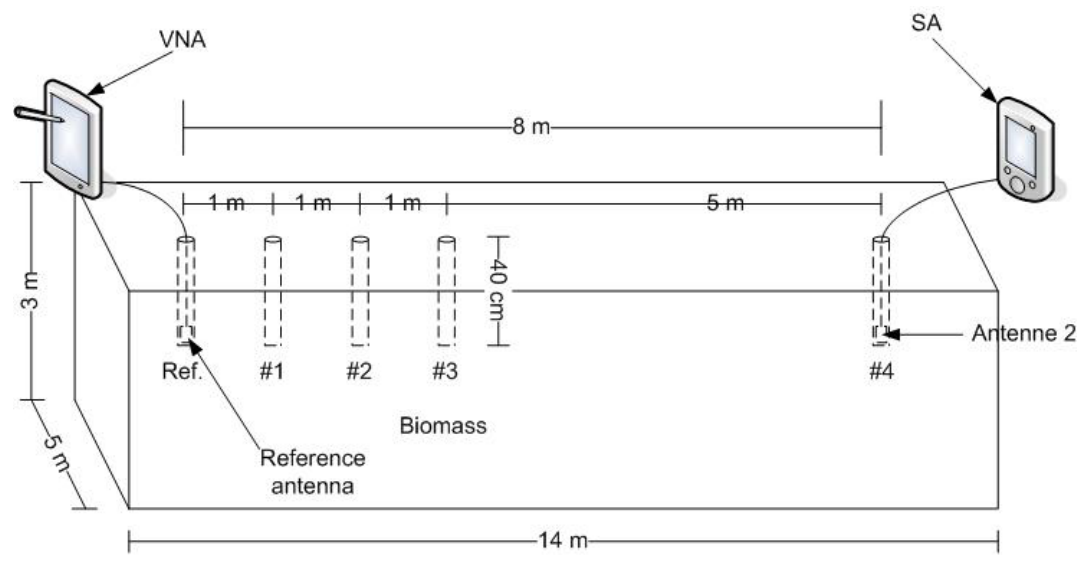
Figure 6. Silage stack dimension and measurement